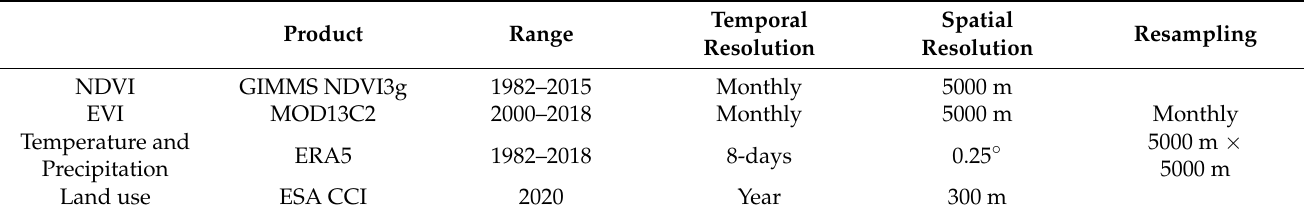
Table 2. Datasets used in this